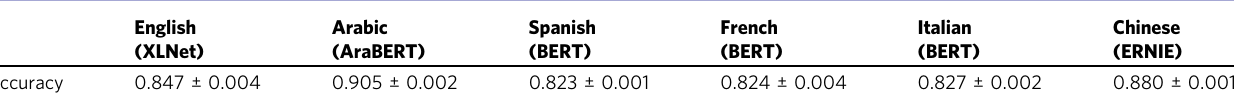
Table 1 Accuracy of classi fi ers (mean ± std of accuracies in the fi vefold